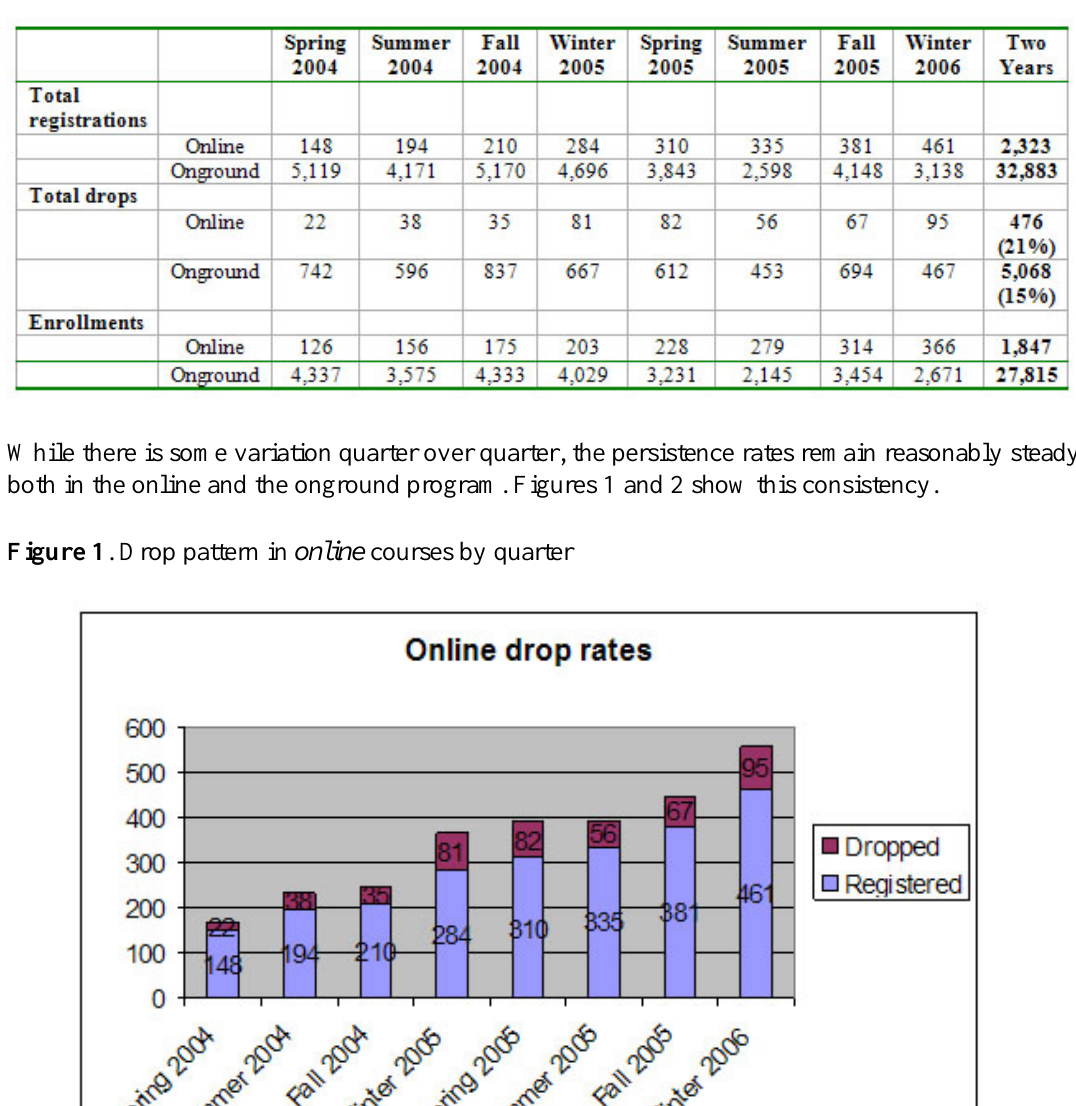
Table 3 : Total course registrations minus total drops